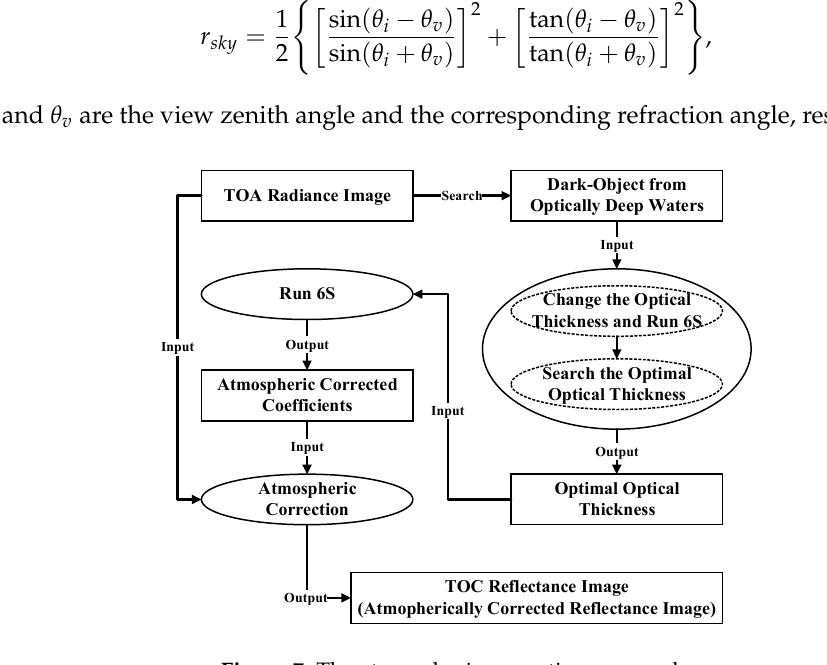
Figure 7. The atmospheric correction approach.